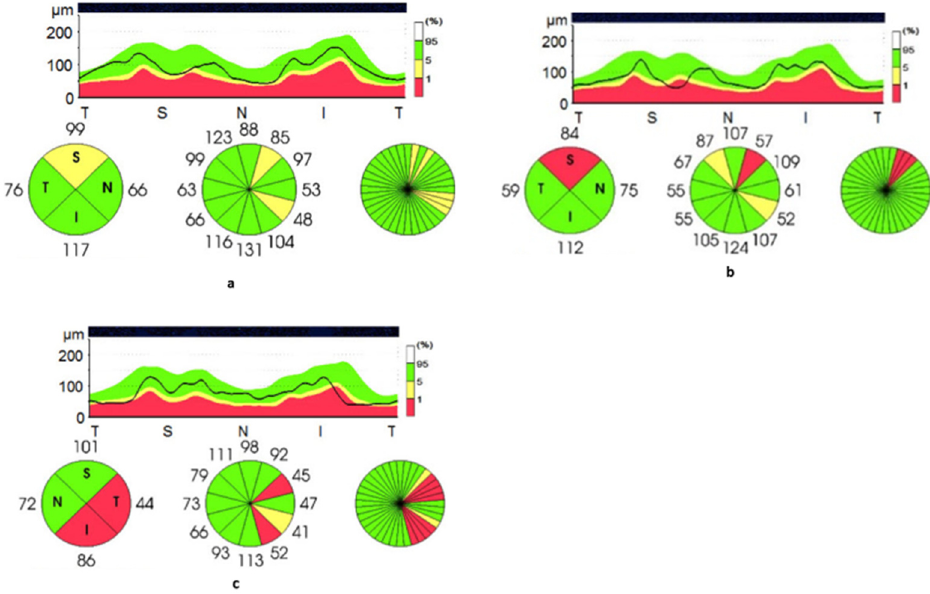
Figure 2. Retinal nerve fibre layer thickness of patients with FRDA. This figure demonstrates reduced sectorial superior quadrant thickness in patients 42 ( a ) and 5 ( b ), and reduced temporal and inferior quadrant thickness in patient 45 ( c ). Pie graphs of quadrants (T = temporal; S = superior; N = nasal; I = inferior) and RNFL circular tomogram representing quantitative analysis of RNFL thickness (black line) and normative data set (green area = 95% confidence interval, yellow area = 99% CI, red area = outside 99% CI).